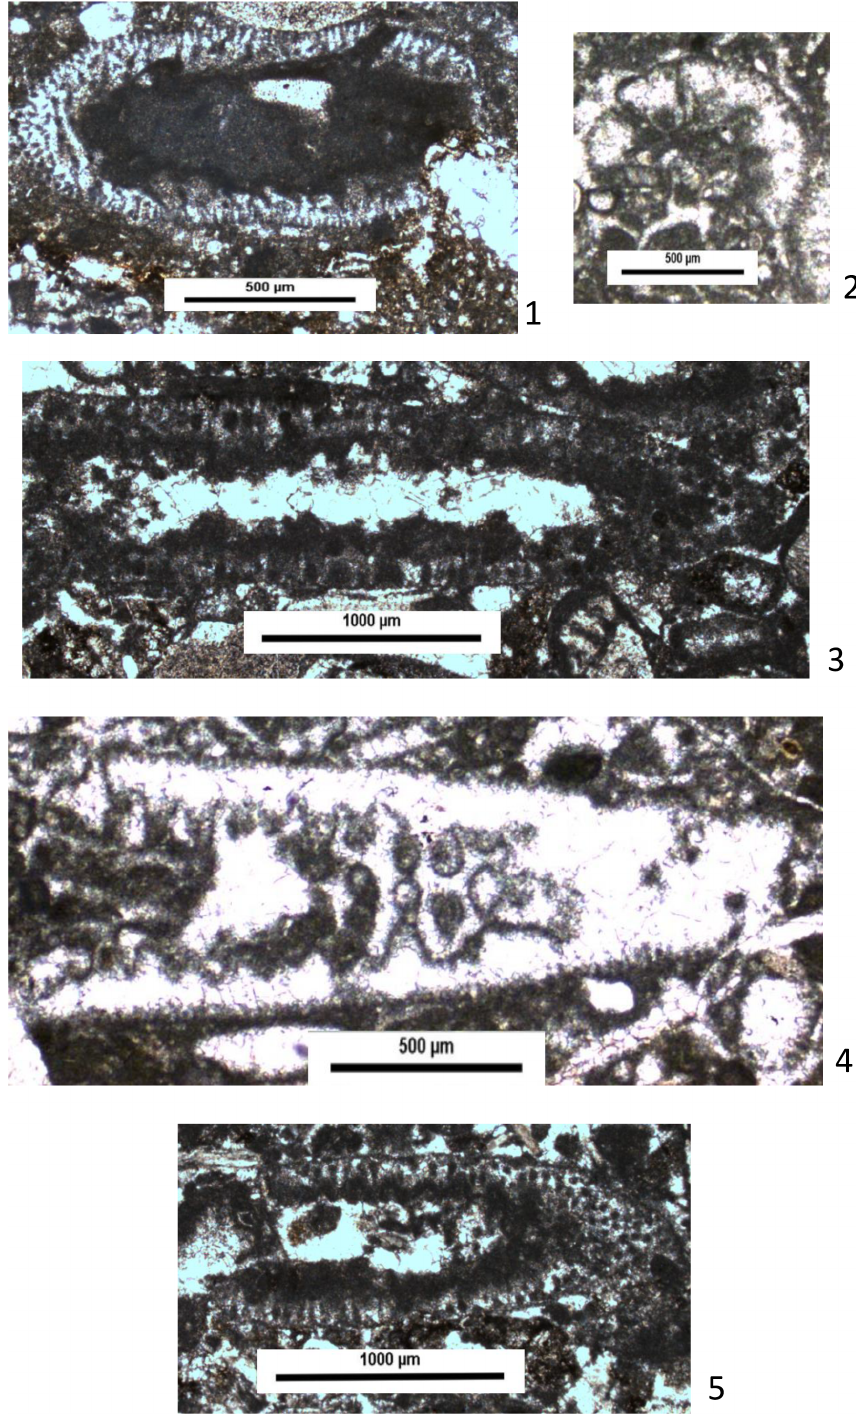
Figure 11. Thin-section photographs of calcareous algae from the Derdere Formation at Derik: (1) Halimeda sp., sample DRK29, and (2–5) Trinocladus tripolitanus Raineri, samples DRK8 (2, 4) and DRK10 (3, 5)